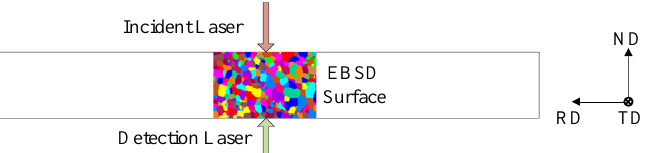
Figure 1. Schematic of specimen with the normal direction (ND) aligned with the ultrasonic wave propagation direction, the rolling direction (RD) corresponding to the length of the specimen, the transverse direction (TD) to the width, and the EBSD observations were made in the RD-ND plane in the region where the ultrasonic pulse propagates through. (Color online).